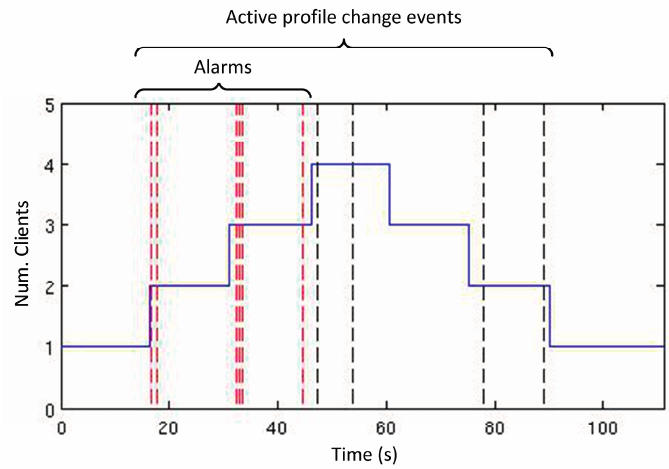
Figure 10. Number of clients along experiments and alarms produced.